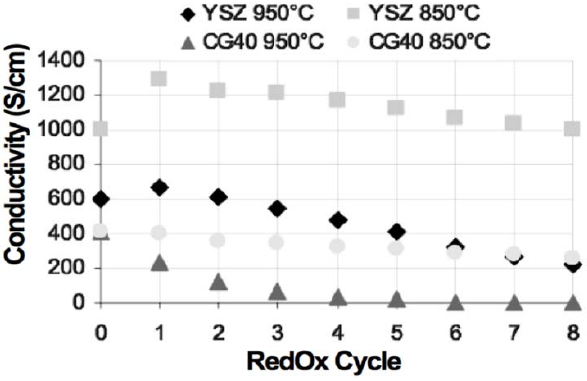
Figure 15. Comparison between Ni-YSZ and Ni-CGO composite electrical conductivity under RedOx treatments